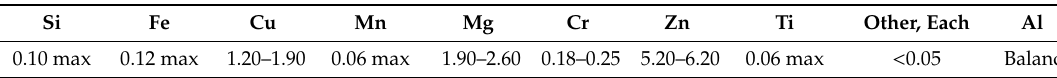
Table 1. Chemical composition of the 7475-T7351 alloy (in wt.%) [4].